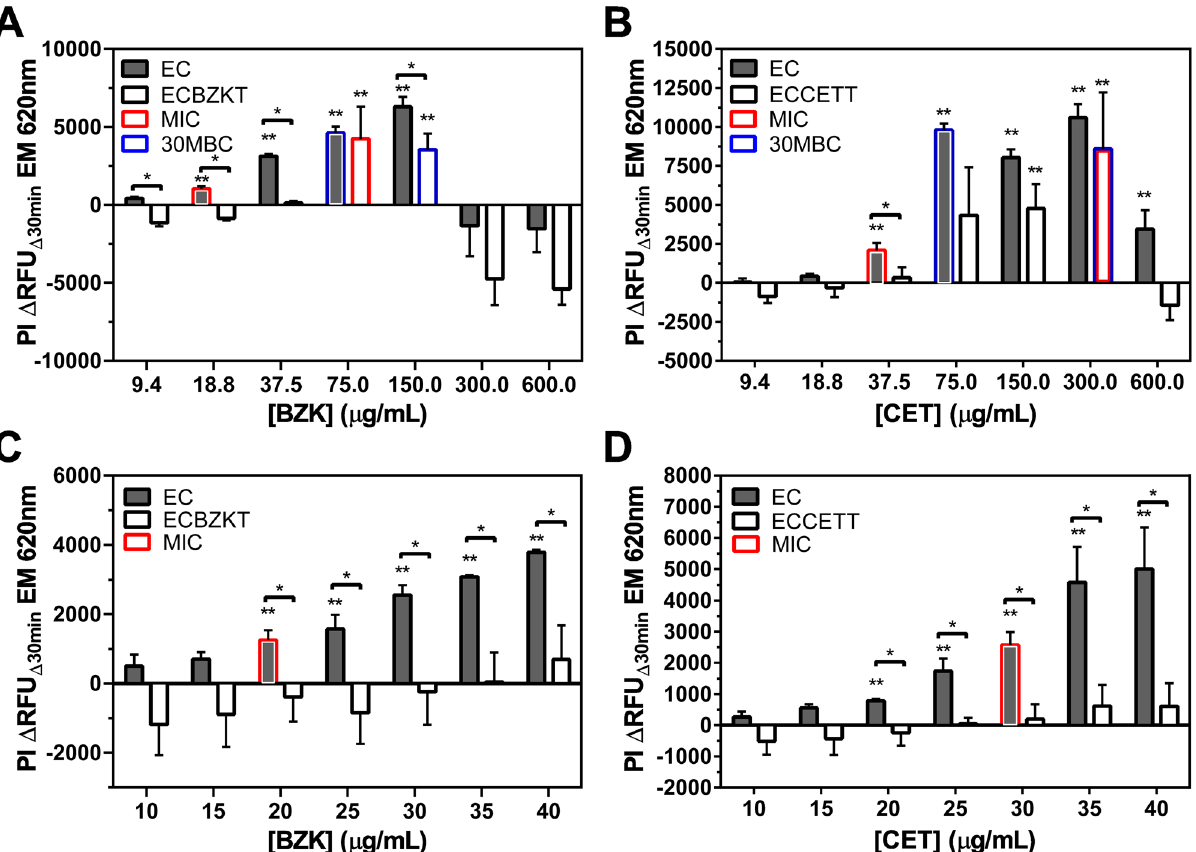
Figure 1. RFDMIA of stationary phase EC, ECBZKT, ECCETT exposed to increasing concentrations of BZK or CET. ( A ) RFDMIA comparison of EC and ECBZKT isolates exposed to BZK. ( B ) Shows RFDMIA results for EC and ECCETT exposed to CET. ( C ) Narrow range RFDMIA of BZK concentrations (10–40 μg/mL). D ) RFDMIA of EC versus ECCETT exposed to narrow range of CET concentrations (10–40 μg/mL). All graphs are the mean PI Δ RFU Δ30min at EM 620 nm values from stationary phase bacterial isolate preparations separately exposed to increasing QAC concentrations. Bar outlines are color coordinated to indicate QAC concentrations corresponding to the MIC (red) and 30MBC (blue) values of each isolate every panel (Table 1). For each RFDMIA plot shown, a Student’s two-tailed t test was calculated by comparing every QAC concentration PI ΔRFU Δ30min value to the lowest measured QAC concentration PI ΔRFU Δ30min value shown on the plot. t tests were used to identify the lowest QAC concentration in an assay with a significant increase in PI ΔRFU Δ30min value and are indicated as a double asterisk (**) with P < 0.01. Data represents three bacterial bioreplicates (n = 3) measured from averaged technical triplicate